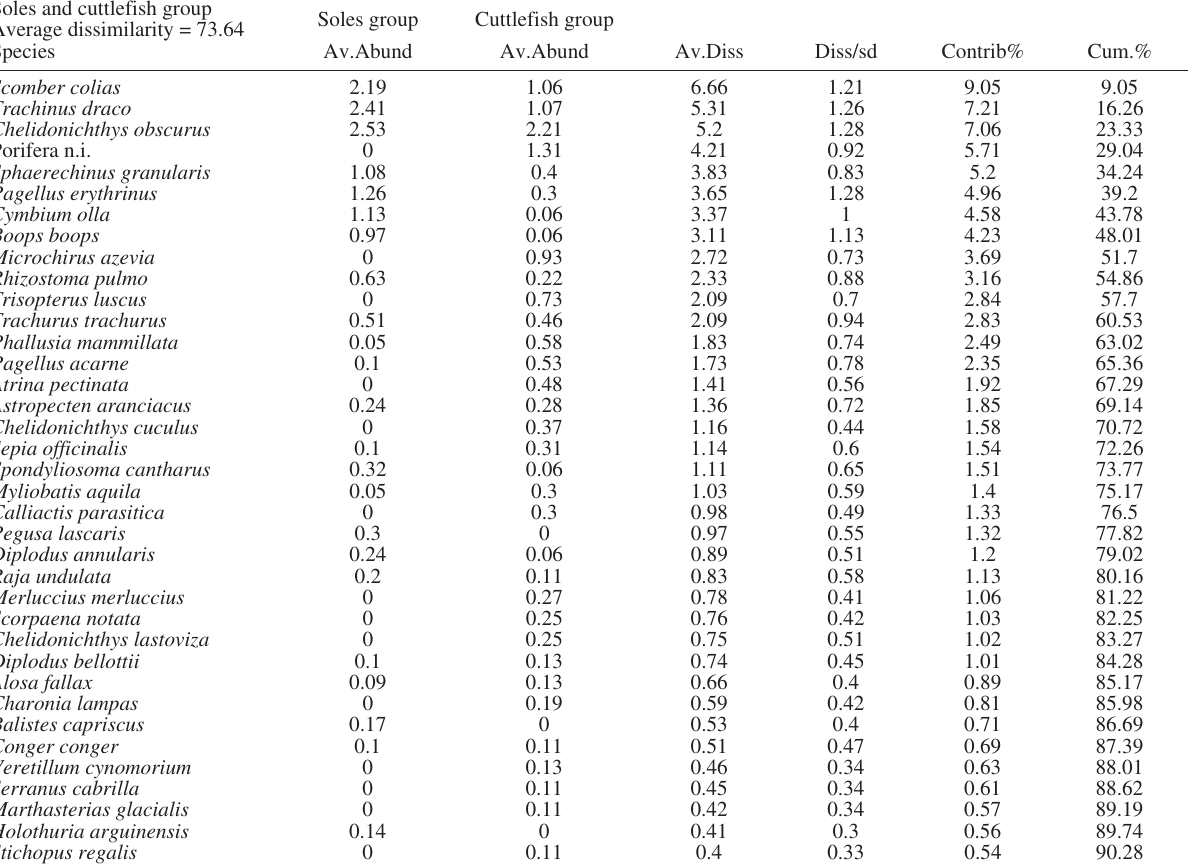
and cuttlefish season).